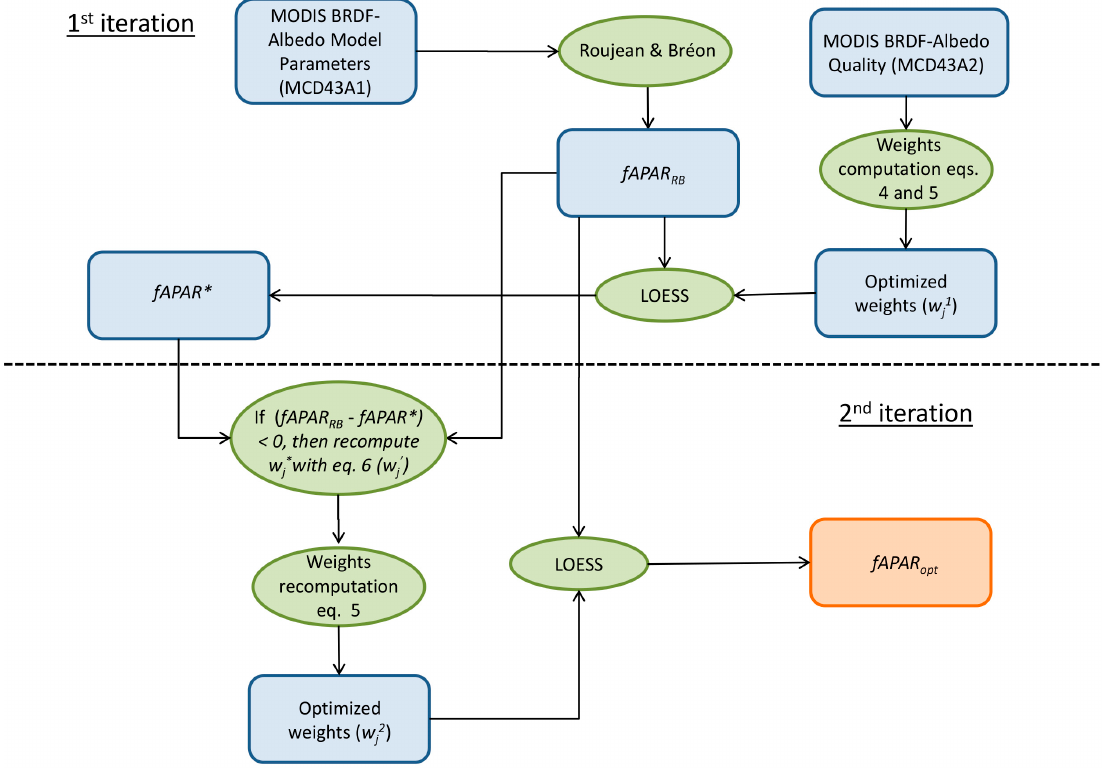
Figure 1. Flowchart of the adapted LOESS algorithm for deriving noise and gap free time series of remotely sensed fraction of absorbed photosynthetic active radiation